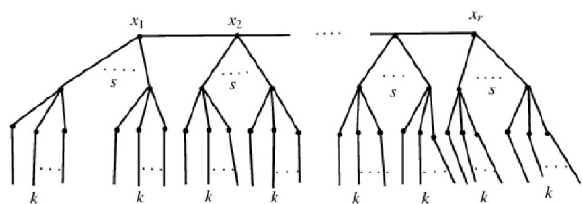
and 6-level pandemic tree Ω 6 5